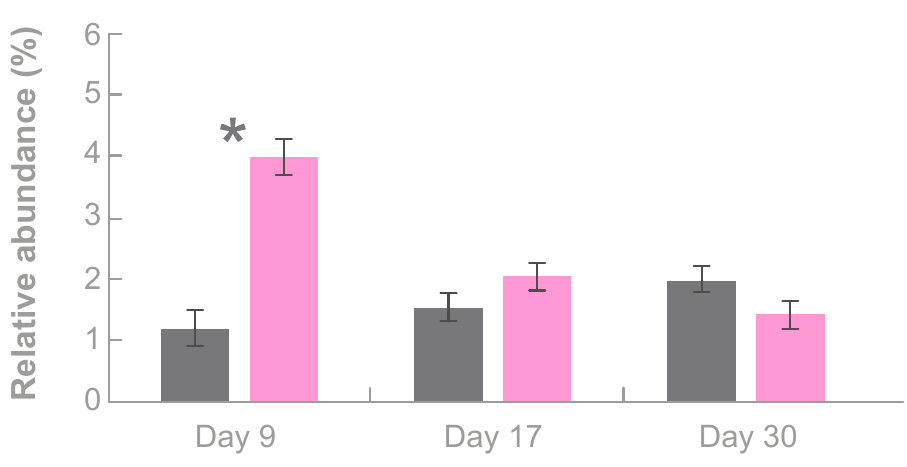
Figure 2. Relative abundance (%) of Lactobacillus species in the gut of 9-, 17-, and 30-day-old piglets in the control (grey bars) and supplemented with Tonisity Px (pink bars) groups. Bars represent LSmeans and error bars denote ± SEM. * Indicates statistical significance between treatments at p < 0.05.